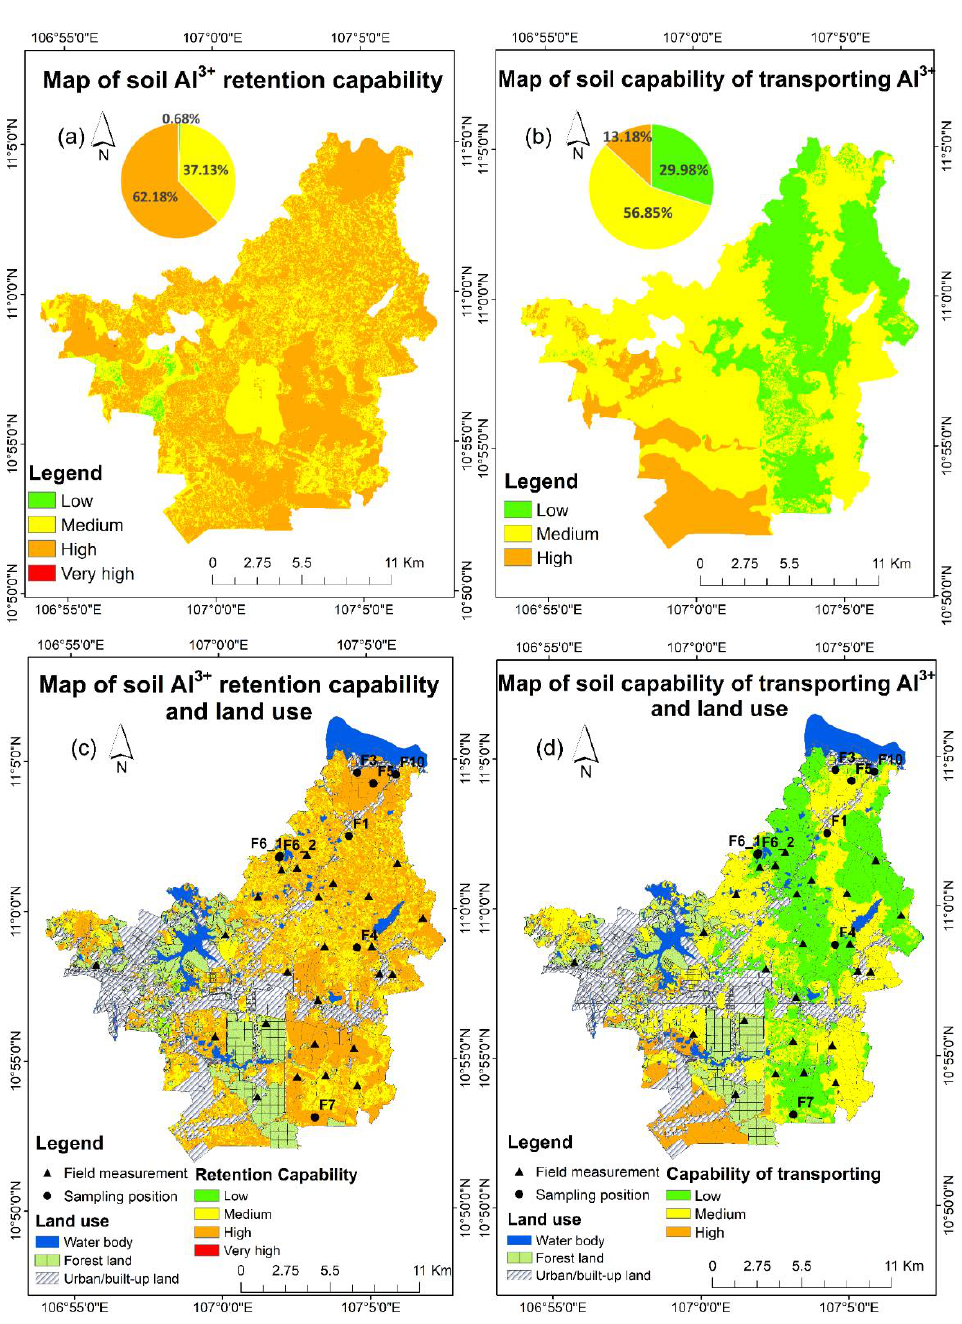
Figure 8. Maps of soil Al 3+ retention capability ( a ) and soil Al 3+ transportation capability ( b ) in Trang Bom district, Dong Nai Province. ( c , d ) show the overlay of types of land use. The triangular points are the soil pH and moisture measuring positions, the circular points are the soil sampling positions.